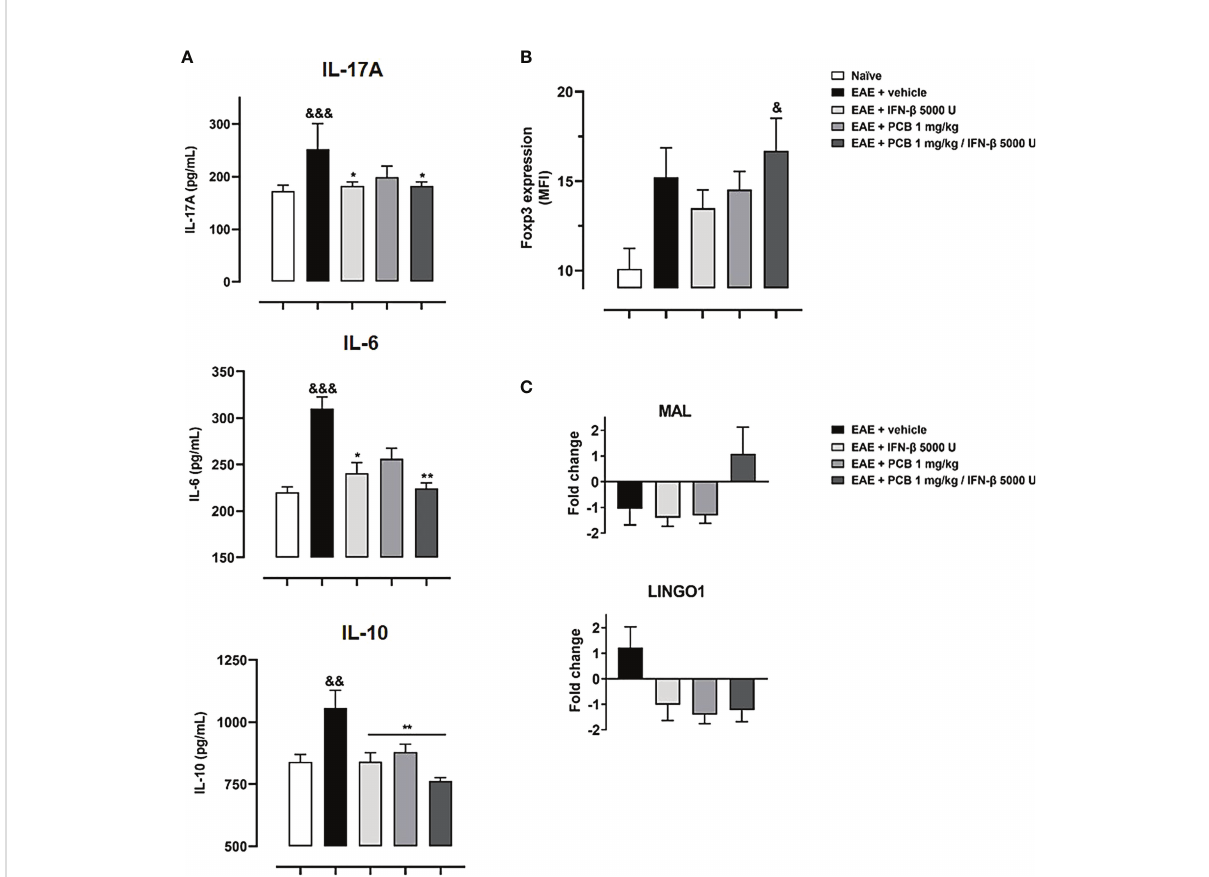
FIGURE 7 Effect of the treatment with the combination PCB/IFN- b and each compound individually on the cerebral expression of cytokines (protein levels) and of demyelinating/remyelinating-related genes (mRNA levels), as well as on the Treg levels in spleen of EAE mice. Panels show (A) the cytokines levels IL-17A, IL-6 and IL-10 from brain as assessed by ELISA, (B) Treg cells from mice spleen analyzed in the CD4 + CD25 high gate and expressed as Foxp3 Mean Fluorescence Intensity (MFI), (C) mRNA levels of LINGO1 and MAL genes as assessed by quantitative Real Time PCR from the mice brain. MOG 35 – 55 immunized mice were treated either with oral PCB at 1 mg/kg daily (once a day), with subcutaneous IFN- b at 5000 U every other day, or with their combination, initiating at day 0 (prophylactic schedule), or after the occurrence of the fi rst disease symptoms at day 14 post-induction (late therapeutic schedule), lasting until day 24 post-immunization. Data are expressed as mean ± S.E.M. (n=4-7 per group). The ampersand (&) and asterisk (*) are indicative of signi fi cant differences in comparison to non-immunized naïve and to vehicle-treated EAE mice, respectively. (*p<0.05, **p<0.01, & p<0.05, && p<0.01, &&& p <0.001, Kruskal-Wallis + Dunn ’ s tests when compared with EAE + vehicle group for IL-17A and IL-16, or according to ANOVA + Newman-Keuls tests for IL-10 and MFI of